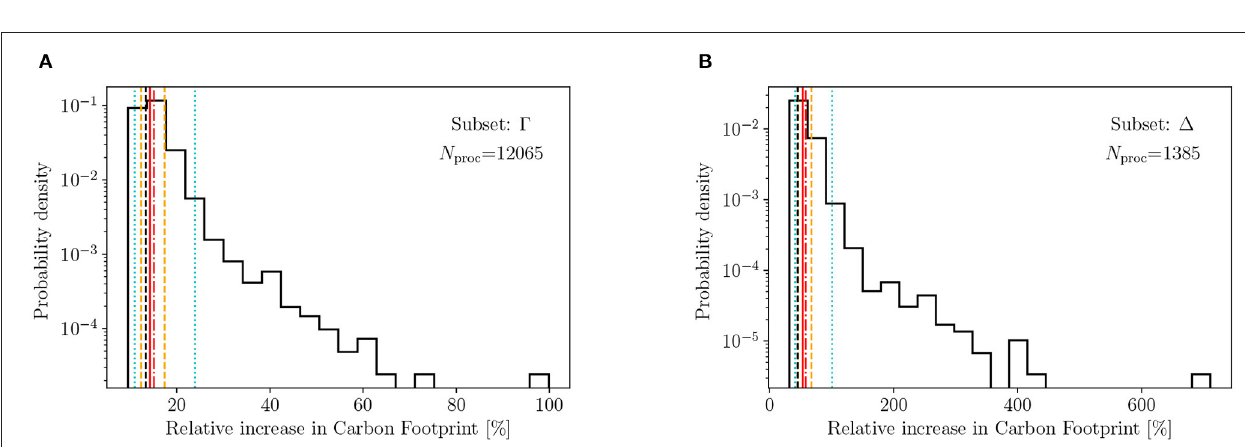
FIGURE 4 | The uncertainty distribution of the relative increase in carbon footprint (GWP100) due to hybridisation, using the “binary” double counting correction method, for the overall hybrid footprint (A) and the 1,385 processes with a price sampling variance from the BACI trade data based on produced commodity and region (B) . The dotted (cyan) and dashed (orange) vertical lines indicate the 95% and 68% confidence intervals, the red solid and dashed dotted lines show the median and mean of the distribution. The black dashed line indicates the impact using the ecoinvent